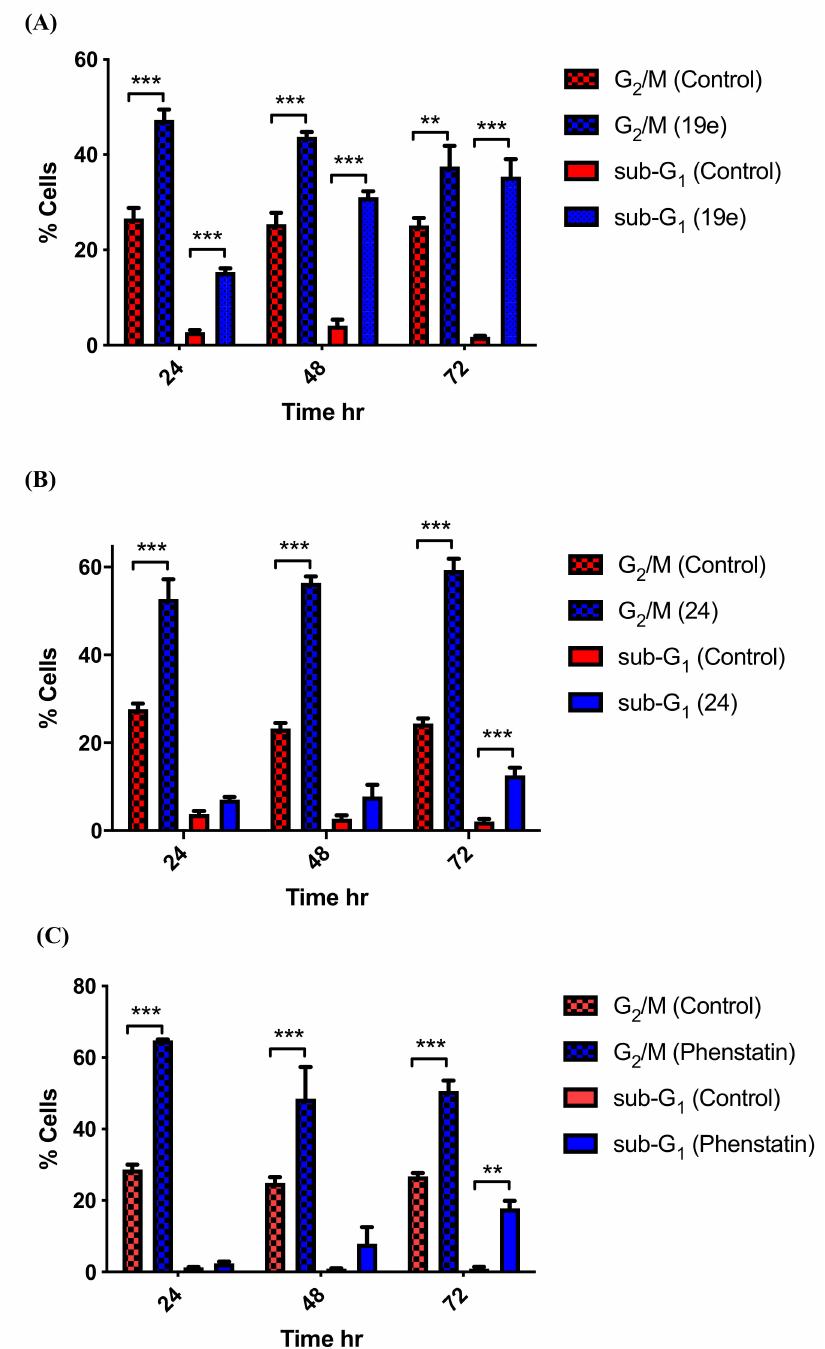
Figure 8. Compound ( A ) 19e , ( B ) 24 , and ( C ) phenstatin ( 7a ) in MCF-7 induced G2/M arrest followed by apoptosis in a time-dependent manner in MCF-7 cells. Cells were treated with either vehicle control (v) (0.1% ethanol ( v / v )] or compound 19e , 24 , or phenstatin ( 7a ) (1 µ M) for 24, 48, and 72 h). Then, cells were fixed, stained with PI, and analysed by flow cytometry. Cell cycle analysis was performed on histograms of gated counts per DNA area (FL2-A). The number of cells with <2 N (sub-G1), 2 N (G0G1), and 4 N (G2/M) DNA content was determined with CellQuest software. Values represent as the mean ± SEM for three separate experiments. Statistical analysis was performed using two-way ANOVA (**, p < 0.01, ***, p < 0.001). The 1,2,3-triazole compound 24 , which was the most potent compound evaluated in the viability assay, demonstrated the same effects on the relative percentages of cells